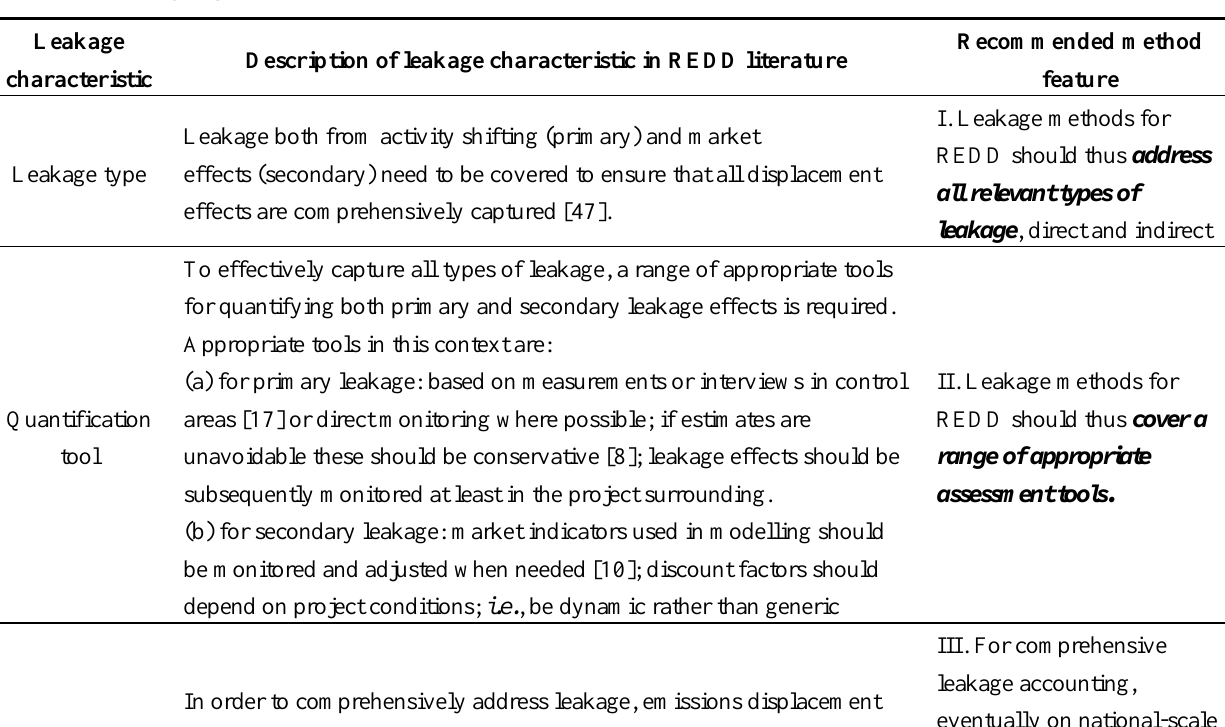
Table 2. Features that leakage quantification methods for REDD should fulfill, based on the three characteristics of the leakage analysis framework (leakage type, quantification tool and geographical scale